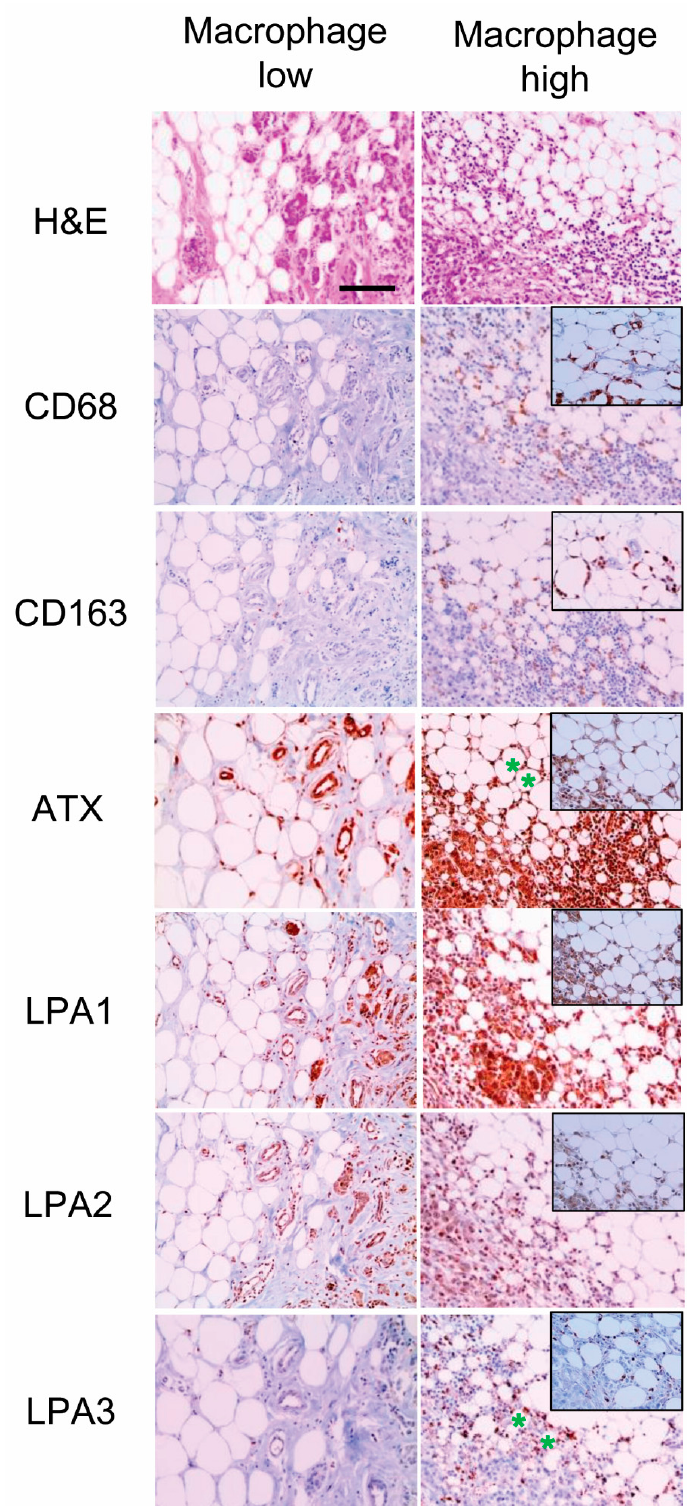
Figure 3. Correlation between the expression of ATX-LPA signaling-related proteins and macrophages in adipose stroma. Increased ATX expression in stromal cells is associated with increased number of CD163-positive macrophages (*). Increased LPA3 expression in stromal cells is associated with high numbers of both CD68- and CD163-positive macrophages (*). Note CD68 and CD163-positive CLS (inlet). Scale bar represents 200 µ